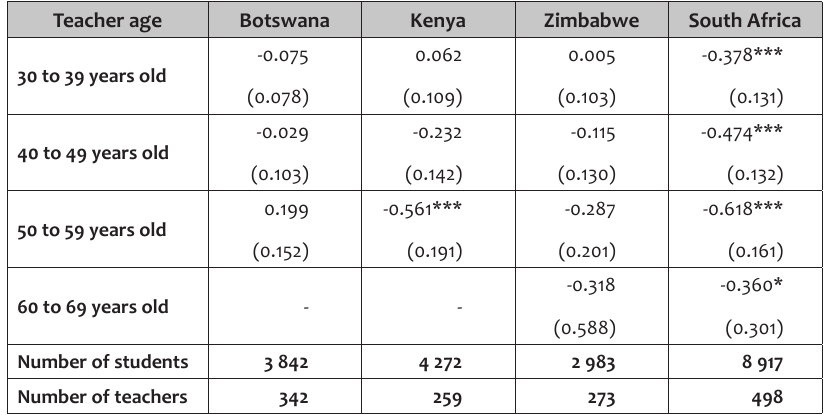
Table 2: LM coefficients on teacher age variables for four SACMEQ countries (Source: Own calculations from SACMEQ III [SACMEQ